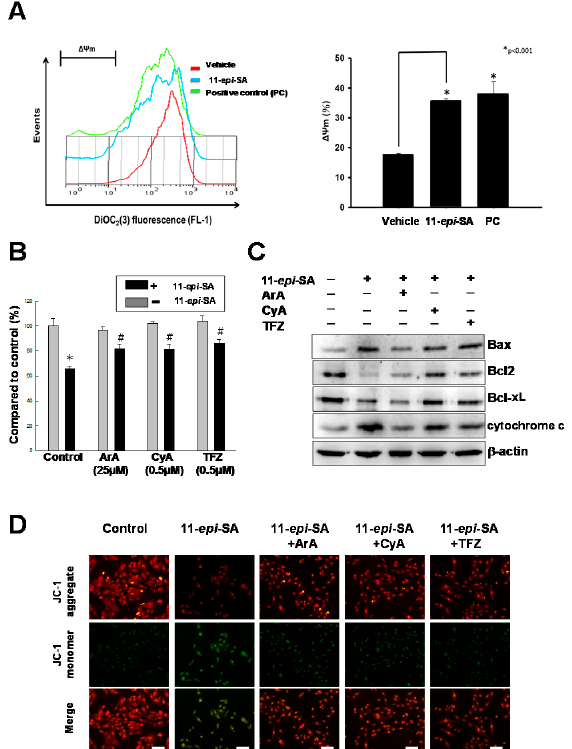
Figure 6. Treatment with 11- epi -SA induces apoptosis through the mitochondria-related